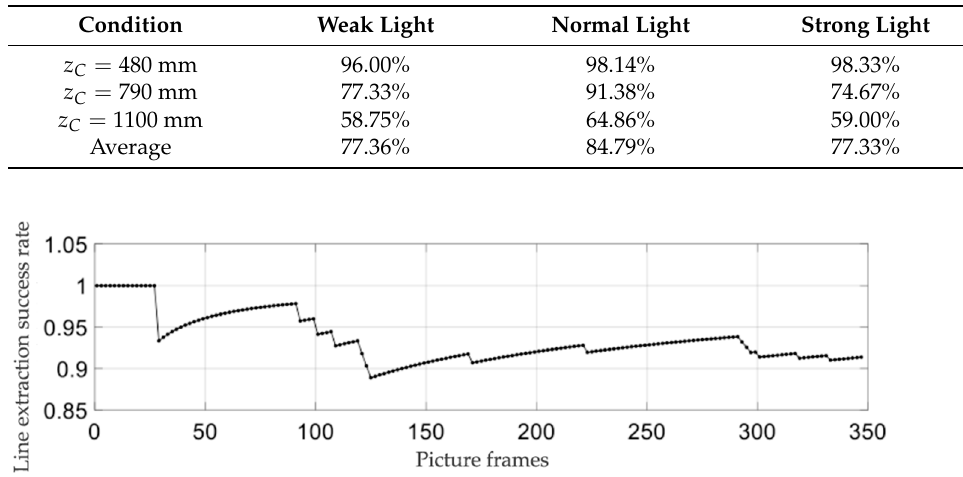
Figure 7. The relationship between line extraction success rate and frames.